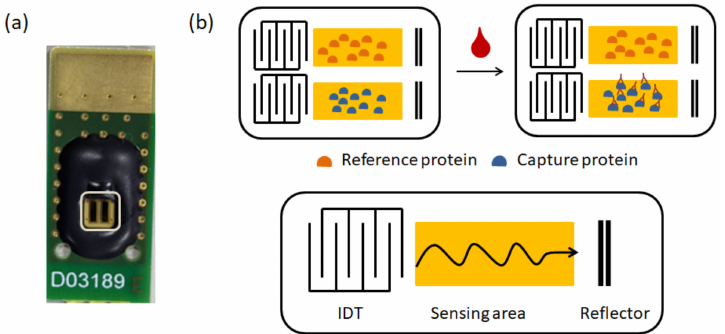
Figure 1. The dual-channel SH-SAW sensor chip. ( a ) Photograph of SH-SAW sensor chip; ( b ) schematic coated proteins in the dual-channel SH-SAW sensor chip.